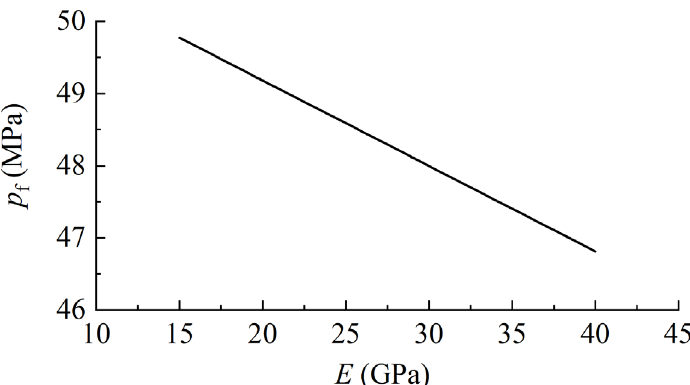
Figure 7. Change in initiation pressure with elastic modulus.